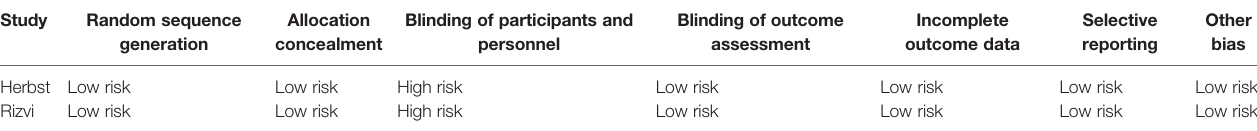
TABLE 3 | The Cochrane collaboration ’ s model for assessing risk of bias of randomized controlled trials.